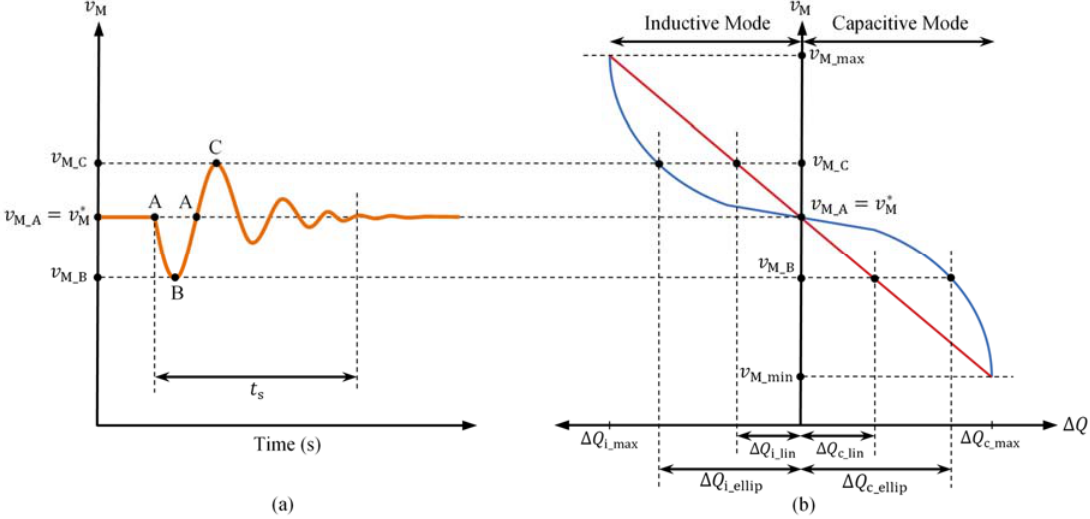
Figure 5. ( a ) Voltage deviations of the AC ‐ bus during abnormal conditions, and ( b ) the corresponding linear (red line) and PLE (blue line) P ‐ f characteristics.